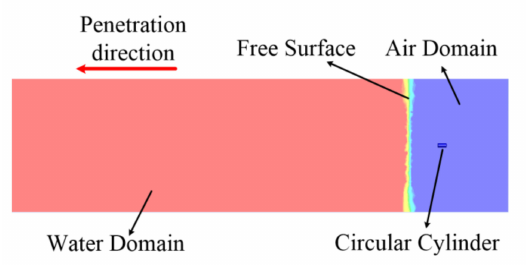
Figure 1. Computational domain and boundary conditions for circular cylinder.